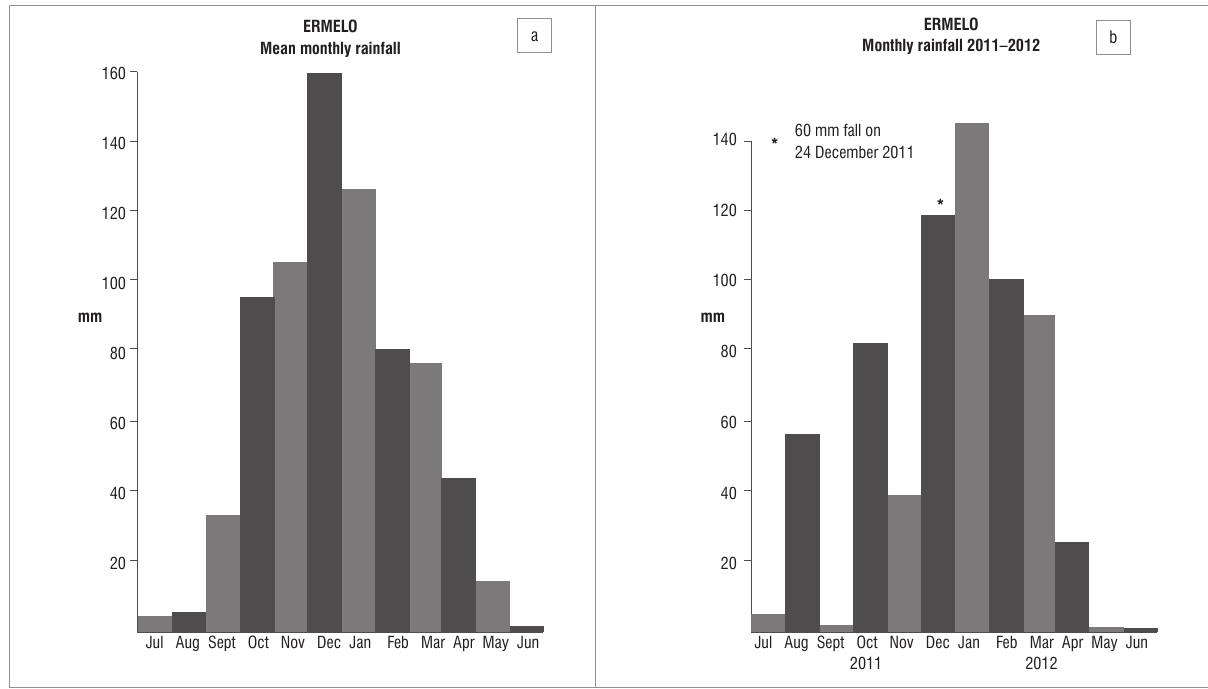
Figure 4: (a) Long-term average monthly rainfall for Ermelo and (b) rainfall over Ermelo in the 2011–2012 season.